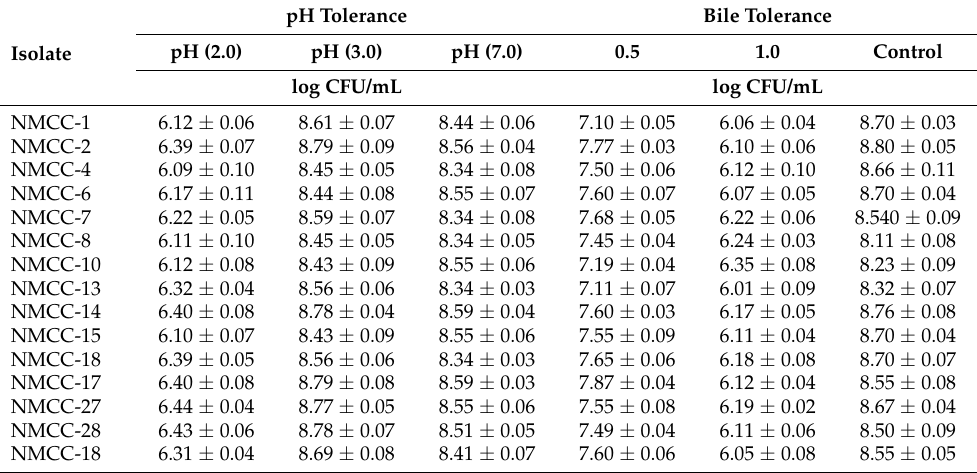
Table 1. Acid and bile salt tolerance of presumptive LAB isolates after 3 h of incubation.